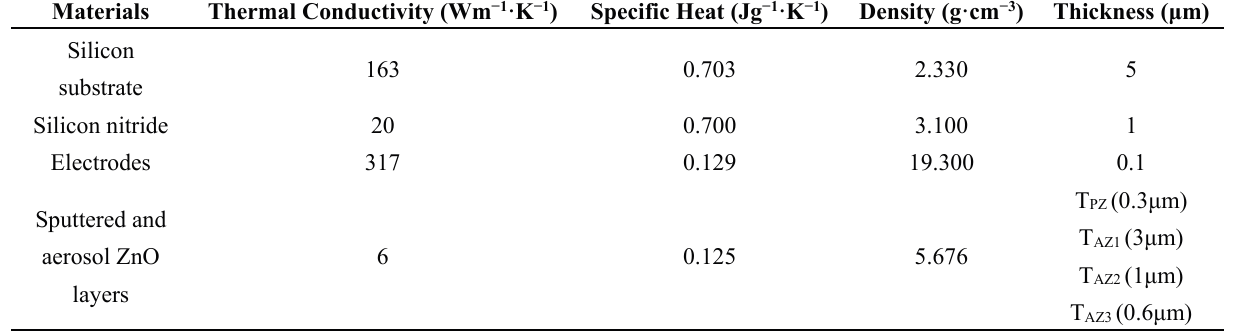
Table 4. Material properties used for the simulation of temperature variation fields.